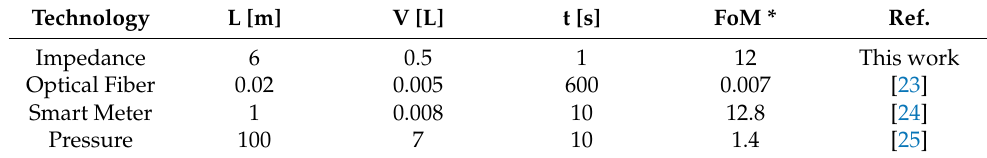
Table 6. Comparison of the sensing performance of different detection techniques with sensitivity to small